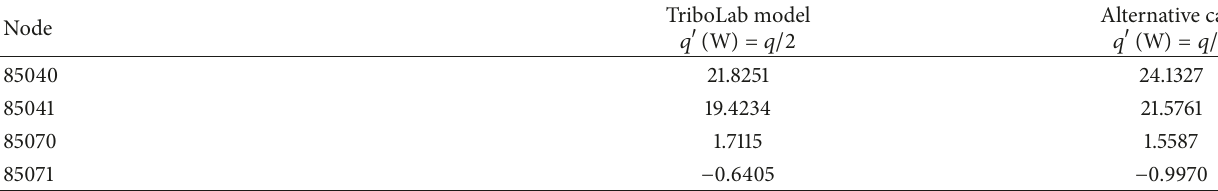
Table 13: Temperature results [ ∘